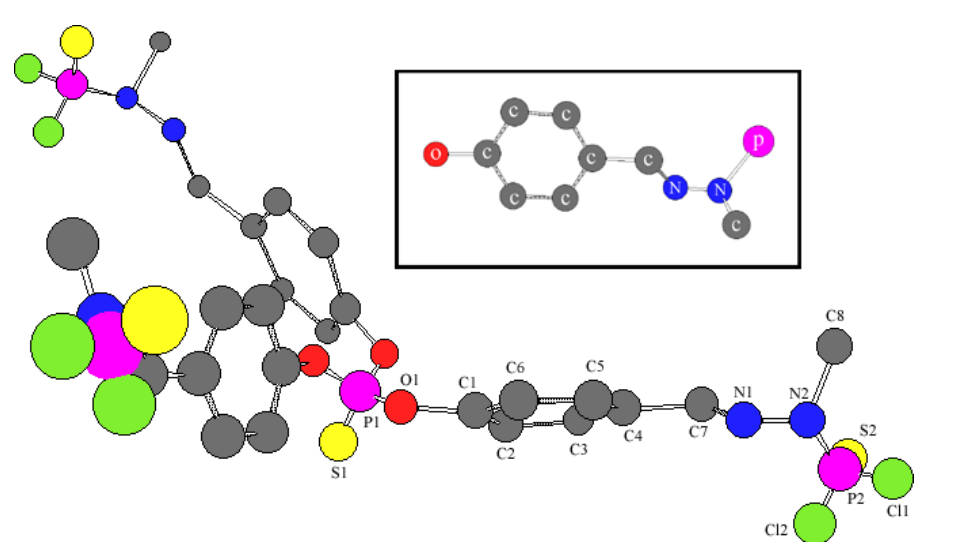
Figure 2. The first-generation dendrimer’s molecular structure [9]. The inset shows the fragment of the repeating unit that corresponds to it.